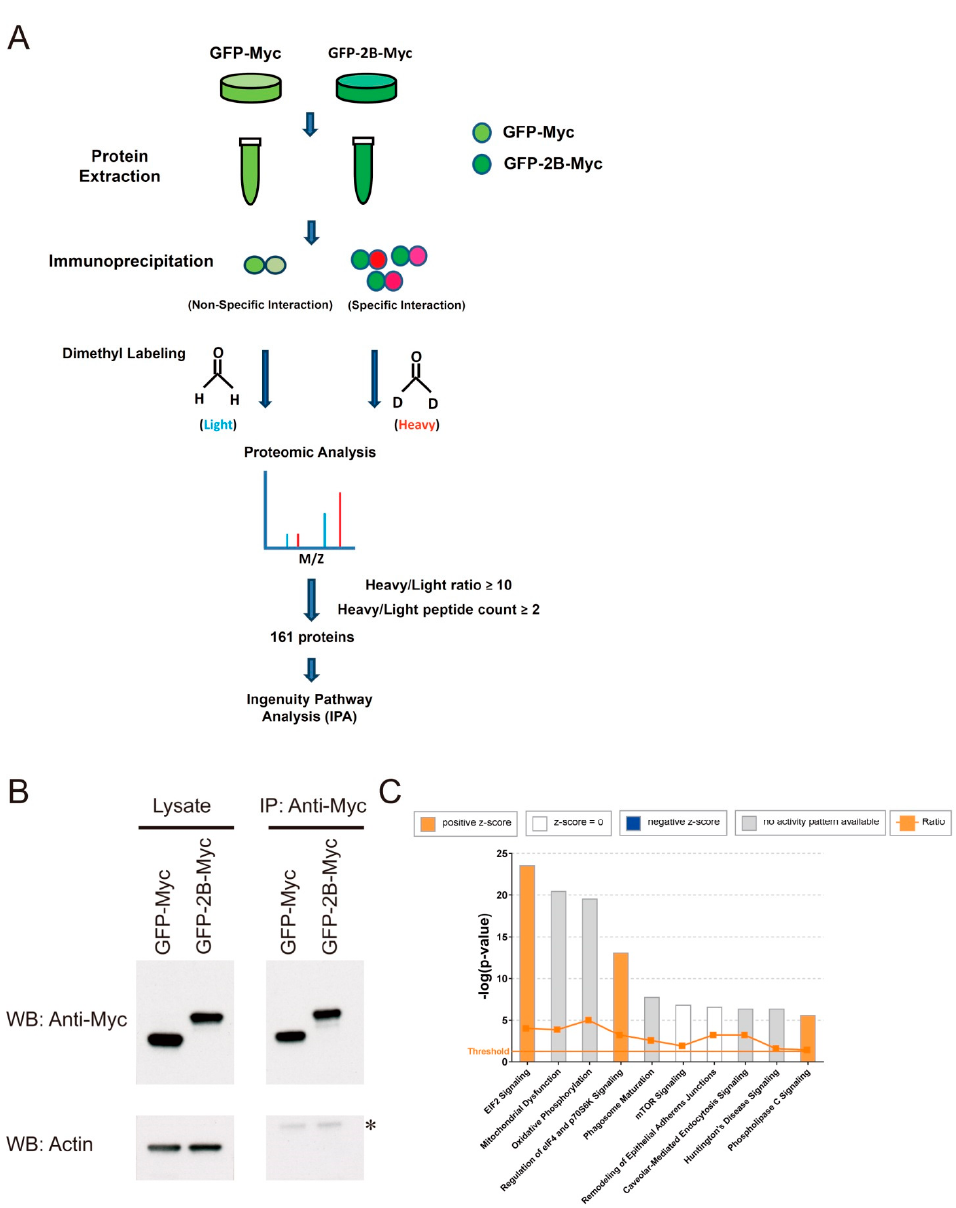
Figure 2. Identification of the 2B ‐ interacting proteins through immunoprecipitation ‐ mass spec ‐ trometry. ( A ) Vero cells were transfected with vectors encoding GFP ‐ Myc (control) or GFP ‐ 2B ‐ Myc proteins, and lysates were prepared. Immunoprecipitation with the anti ‐ Myc antibody was fol ‐ lowed by tryptic digestion and labeling with light (hydrogen) and heavy (deuterium) stable ‐ isotope dimethyl formaldehyde. Peptides were analyzed by the strong cation exchange (SCX)/reverse ‐ phase nanoscale liquid chromatography (LC) coupled with Orbitrap Elite hybrid mass spectrometer. The proteins with heavy/light ratio ≥ 10 and heavy/light count ≥ 2 were identi ‐